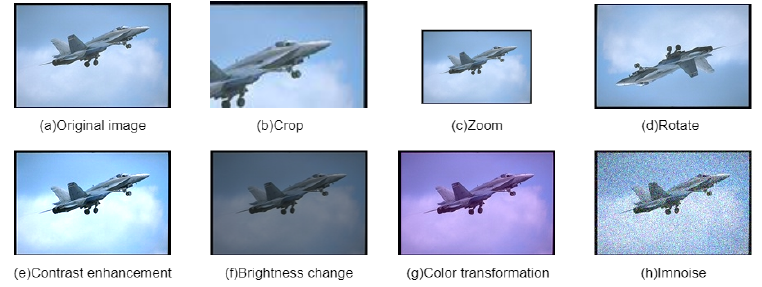
Figure 3. Several data enhancement